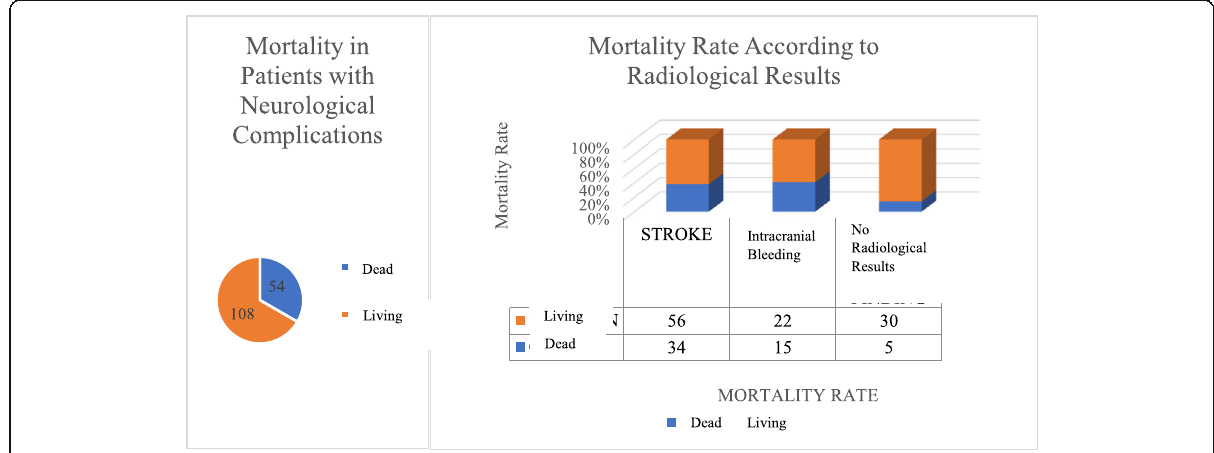
Fig. 2 The mortality rates of patients after classification according to their radiological